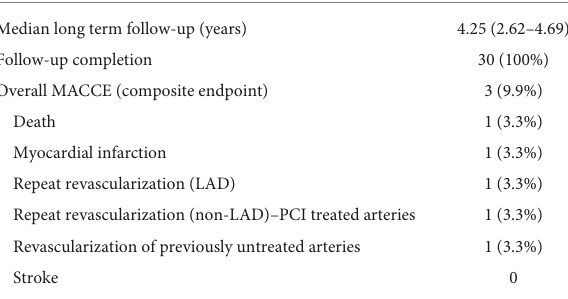
TABLE 5 Long-term observation toward